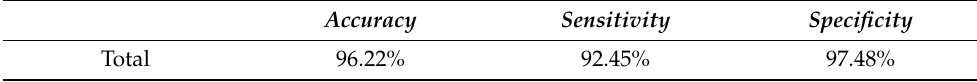
Table 12. Validation Performance.